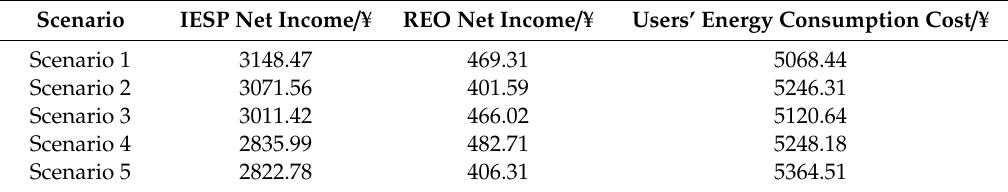
Table 4. Revenues of various agents in di ff erent